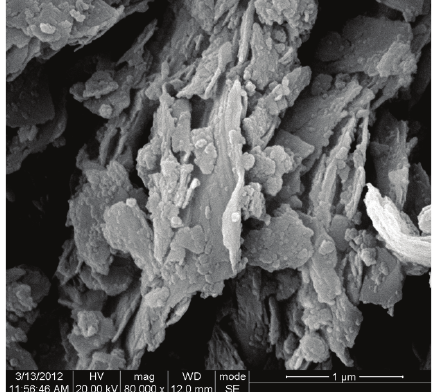
Figure 2: SEM micrograph of VMT powder.